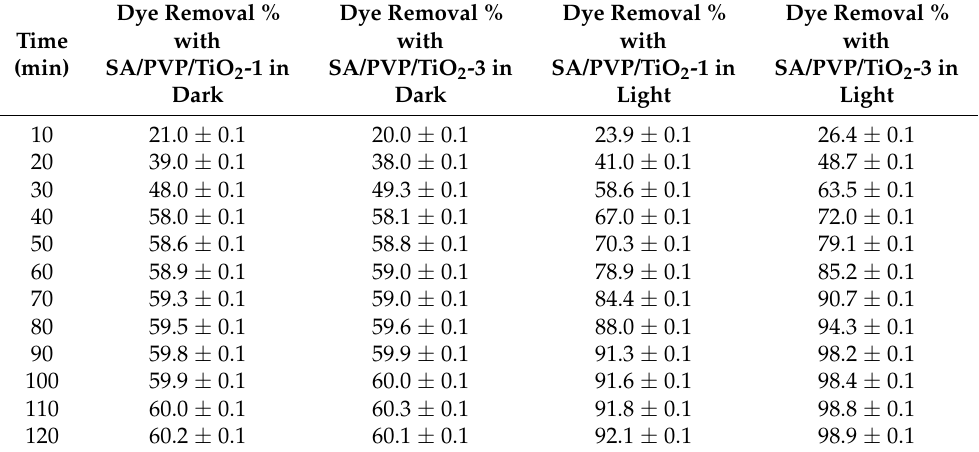
Table 1. Experimental data* on the effect of illumination time on MB dye degradation (%) using SA/PVP/TiO 2 nanocom ‐ posite beads. Dye Removal % with Time (min)